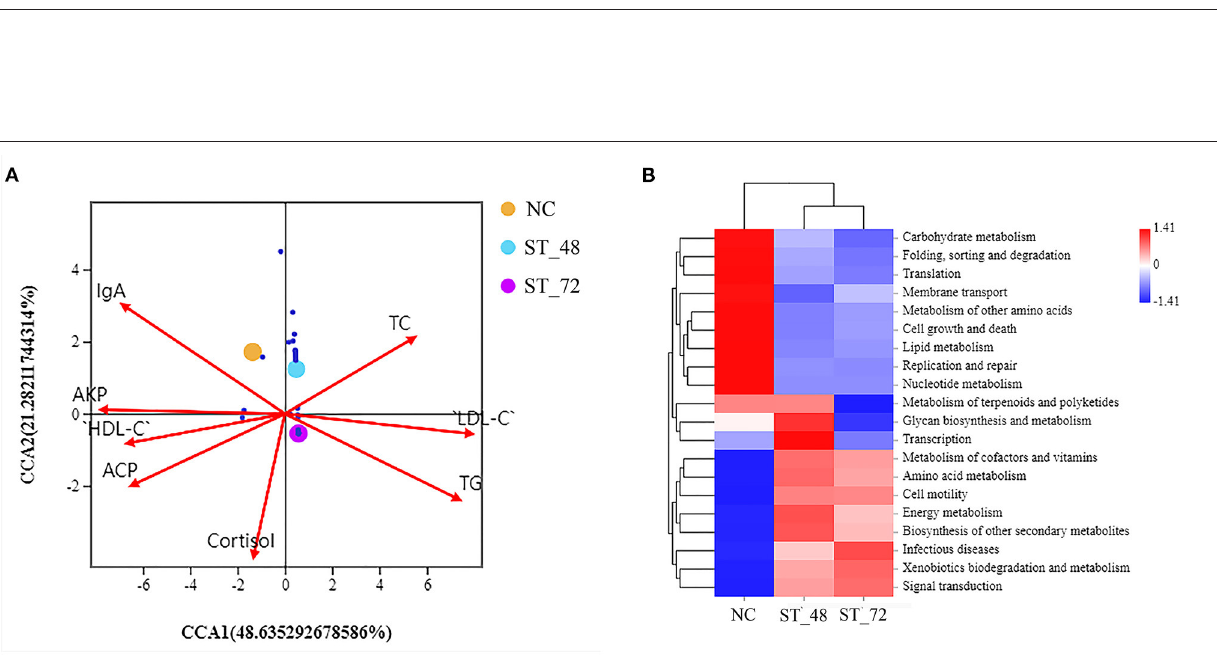
Frontiers in Microbiology |